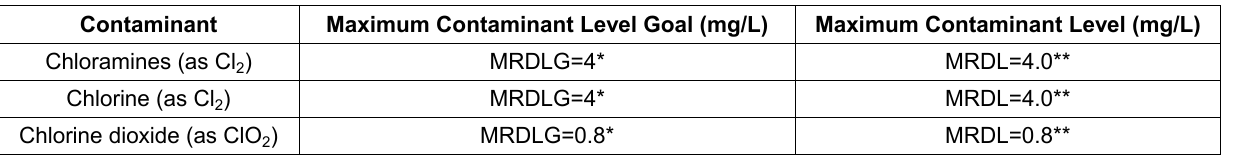
Table 2. EPA national primary drinking water standards for disinfectants.